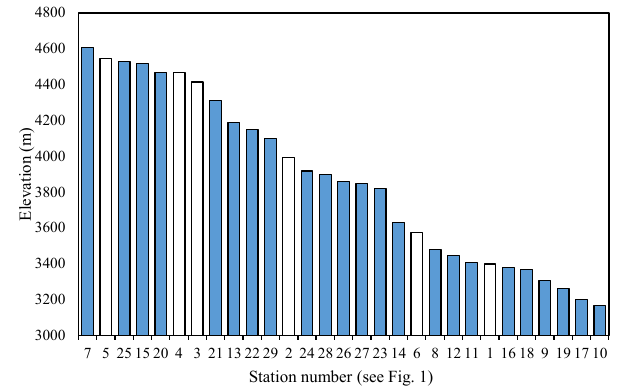
Figure 2. Elevations of all 29 stations included in the study. Bars are numbered and colored in accordance with Fig. 1, with white bars representing SPCC stations and blue bars representing SENAMHI stations.